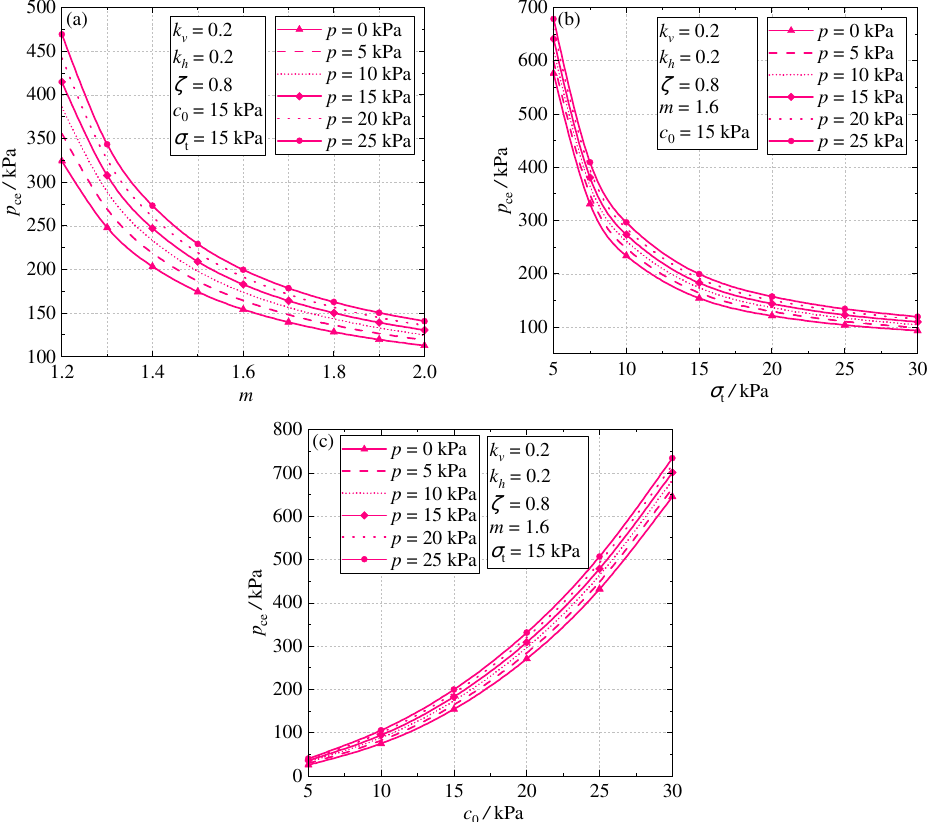
Figure 9. Influence of nonlinear parameters on the seismic bearing capacity: ( a ) initial cohesion; ( b ) uniaxial tension strength; ( c ) nonlinear coefficient.